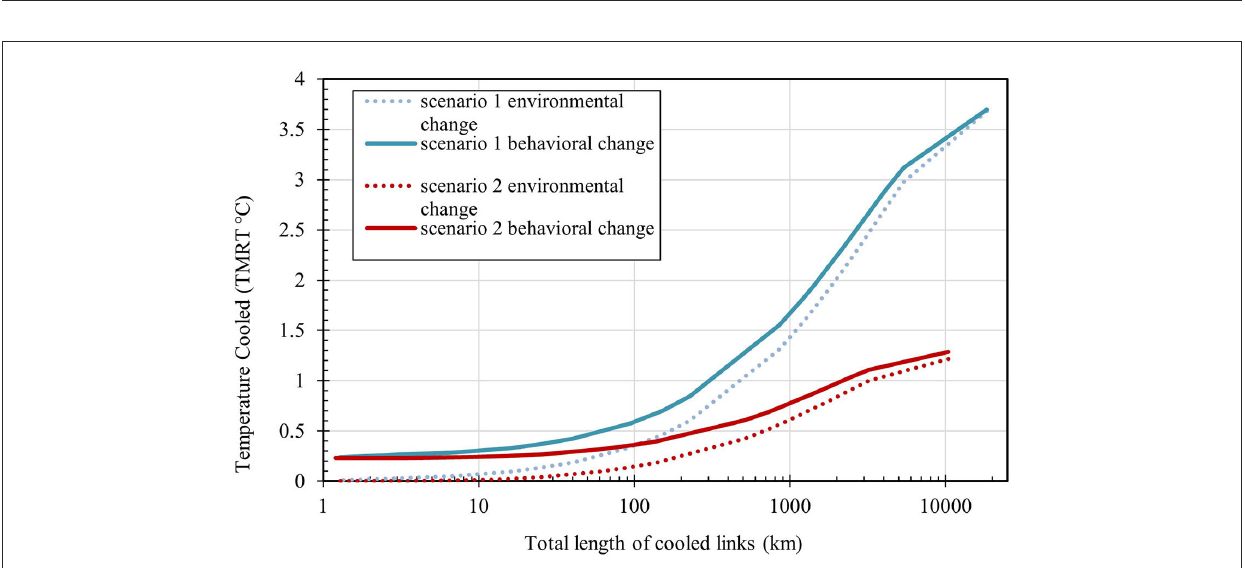
FIGURE4 Average trips’ heat exposure reduction by changing environment and travel behavior. The x-axis represents the total length of the network selected to get environment change. The y-axis represents the average temperature reduced for all trips. The blue lines represent the street’s cooling condition in scenario 1 where the roadways’ temperature is reduced to the lowest 10%. The red lines represent the street’s cooling condition in scenario 2 where the roadways’ temperature is reduced to the lowest